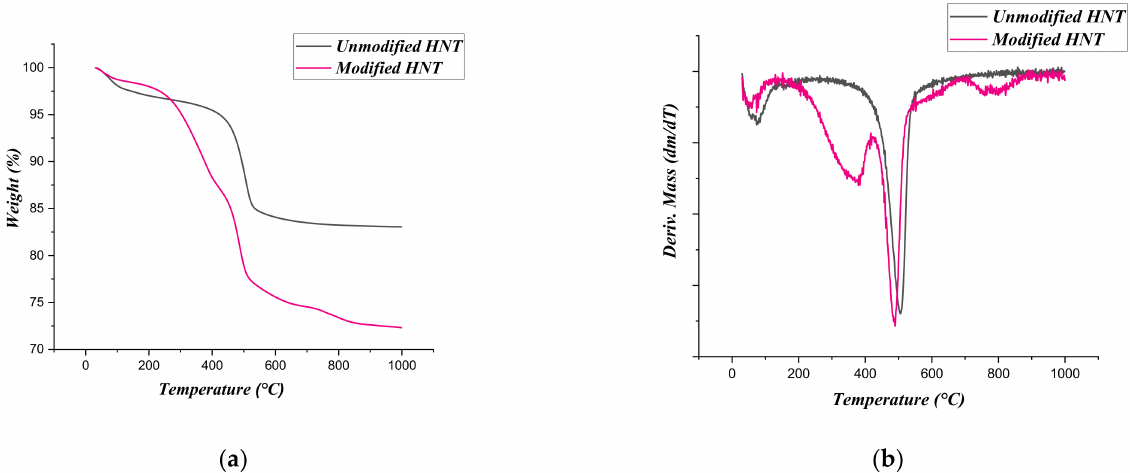
Figure 3. TGA curves of unmodified HNT and modified HNT sample ( a ) and DTG curves of unmodified HNT and modified HNT sample ( b ).